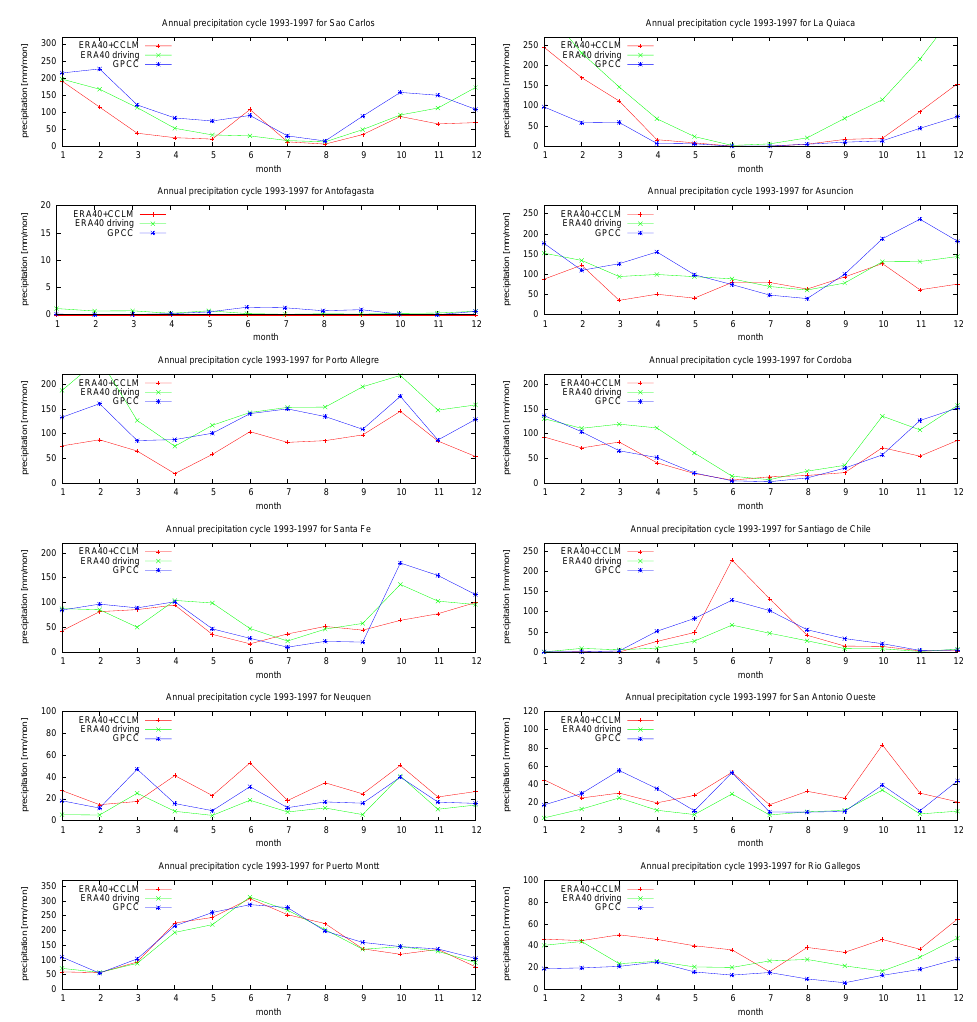
Fig. 2b. Same as Fig. 2a except for the annual precipitation cycle. Red line: ERA40 + CCLM, green line: driving ERA40 re-analysis data, blue line: gridded GPCC dataset based on Figure 2b : same as Fig. 2a except for the annual precipitation cycle. red line: ERA40+CCLM, green line: driving ERA40 re-analysis data, blue line: gridded GPCC data set based on obser- vations.